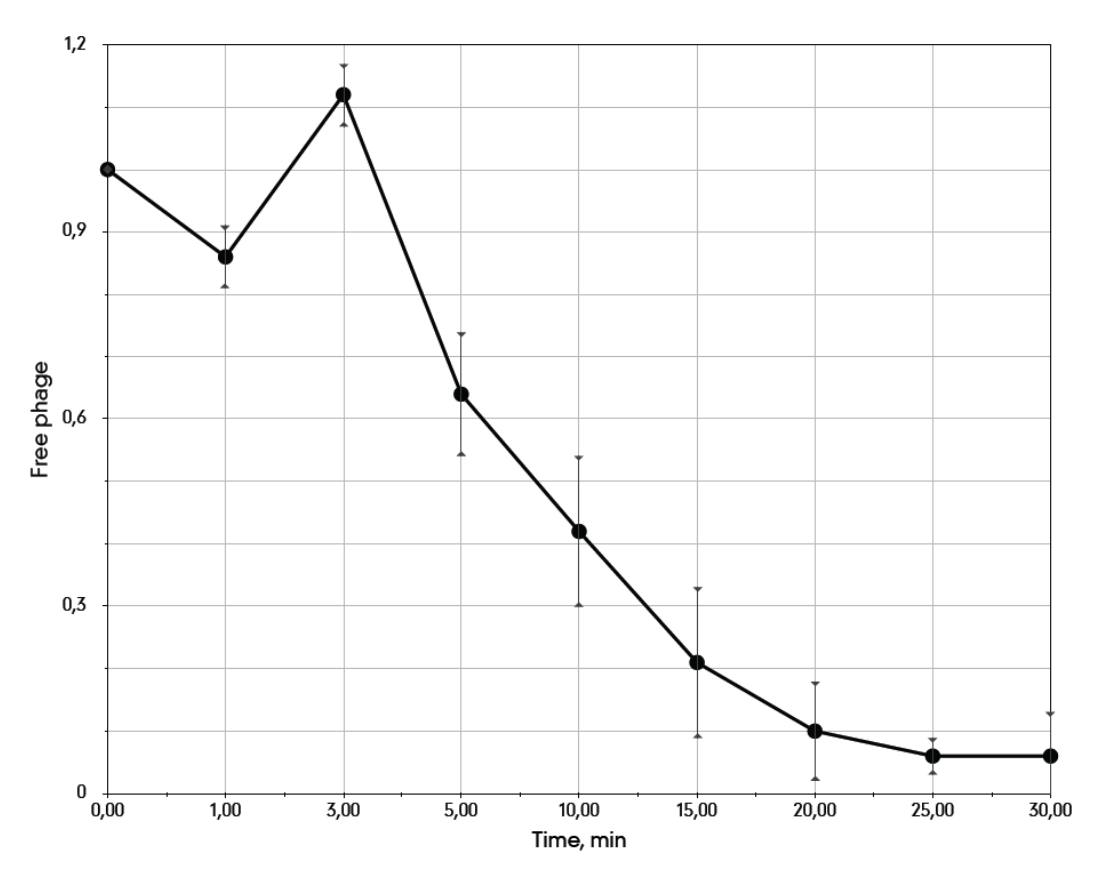
Figure 2. The adsorption curve of the bacteriophage 9g on E. coli C600 cells at 37 °C. The average cells density is 3.1 × 10 7 CFU·mL −1